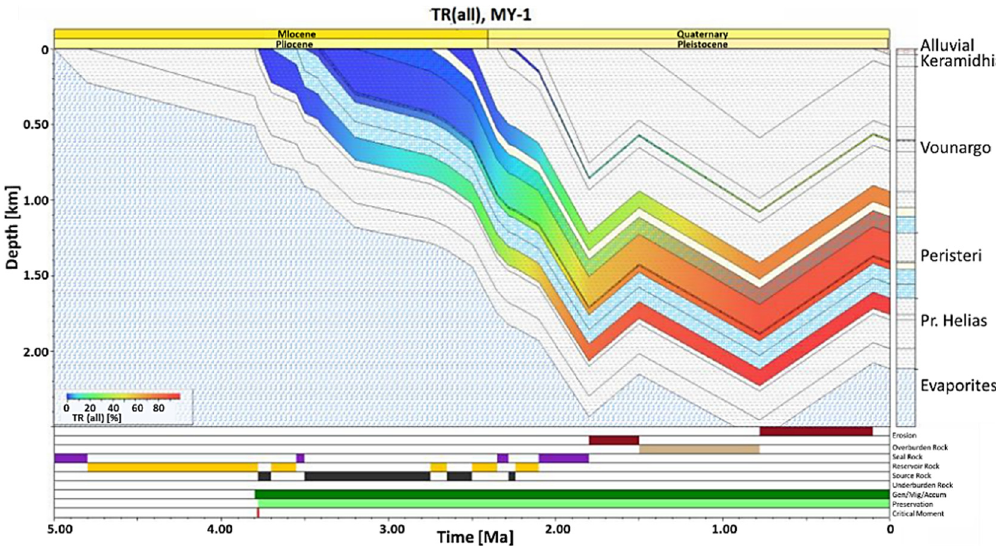
Figure 2. MY-1 1D source rock’s transformation ratio (TR%) model, integrated into the burial history of the MY-1 well location.